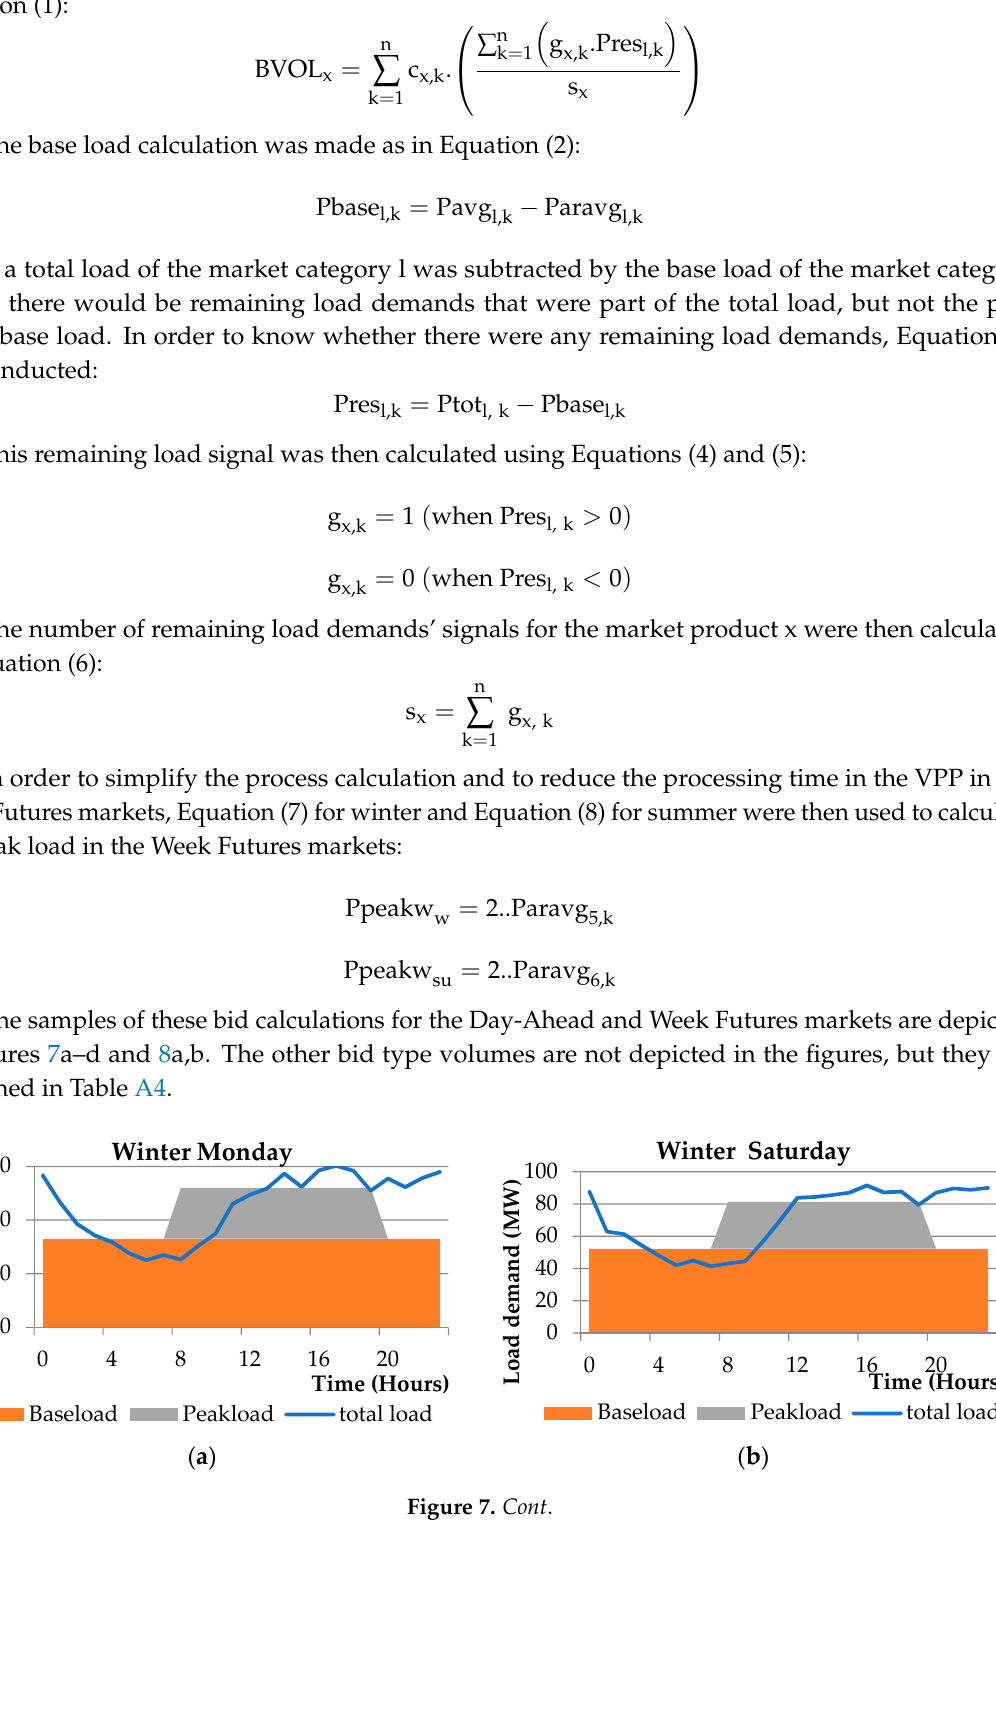
Figure 7. Adapted daily load profile of the base and peak loads for the samples of the Day-Ahead market on: ( a ) Winter Monday; ( b ) Winter Saturday; ( c ) Summer Monday; ( d ) Summer Saturday. ( a ) ( b ) Figure 8. Adapted weekly load profiles of base and peak loads for the Week Futures market: ( a ) Winter Weekly; ( b ) Summer